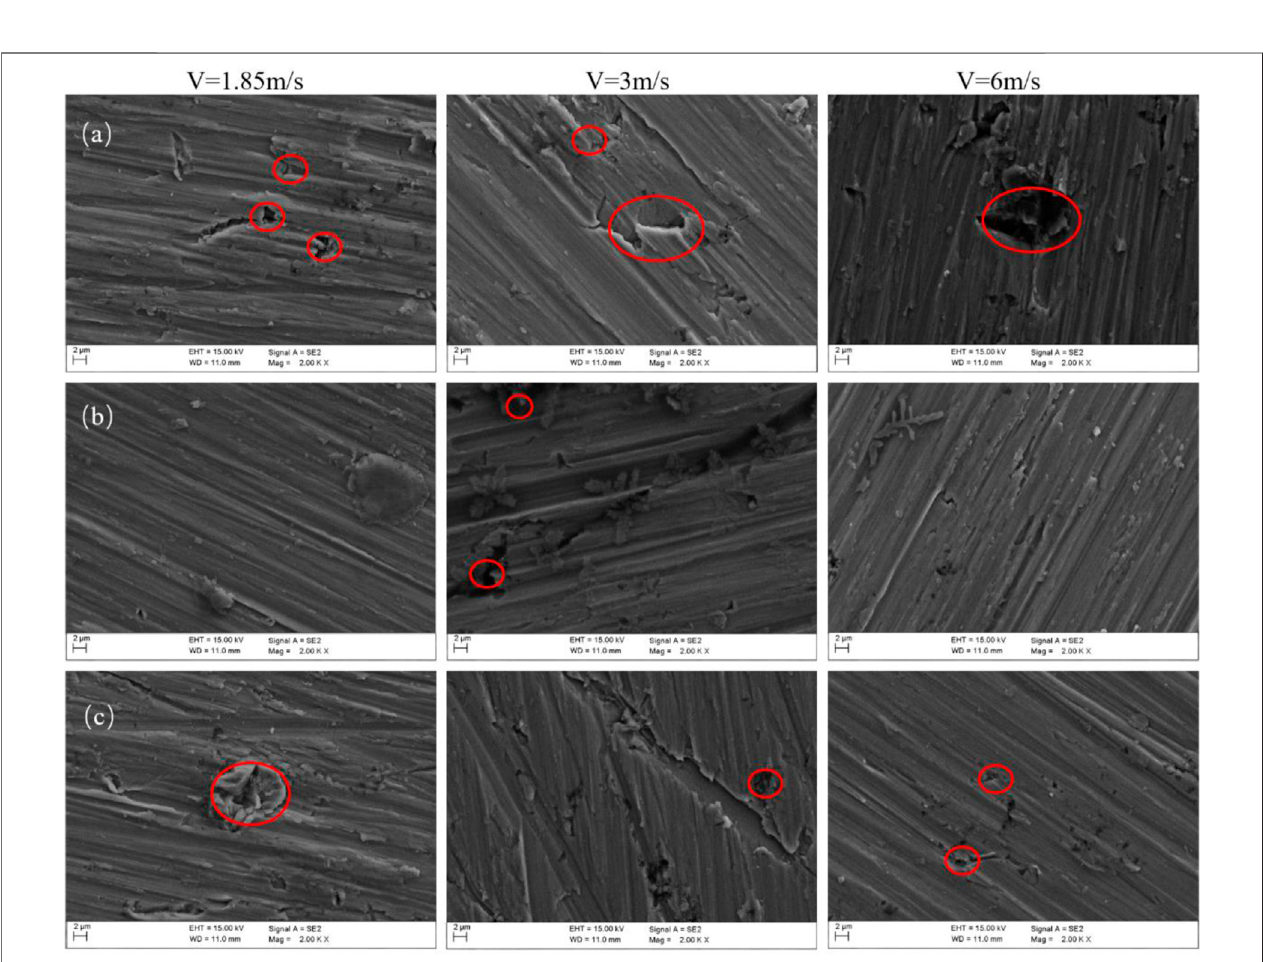
FIGURE 12 | Images of surface morphology after scouring at three fl ow rates: (A) BM, (B) HAZ, and (C) WM.